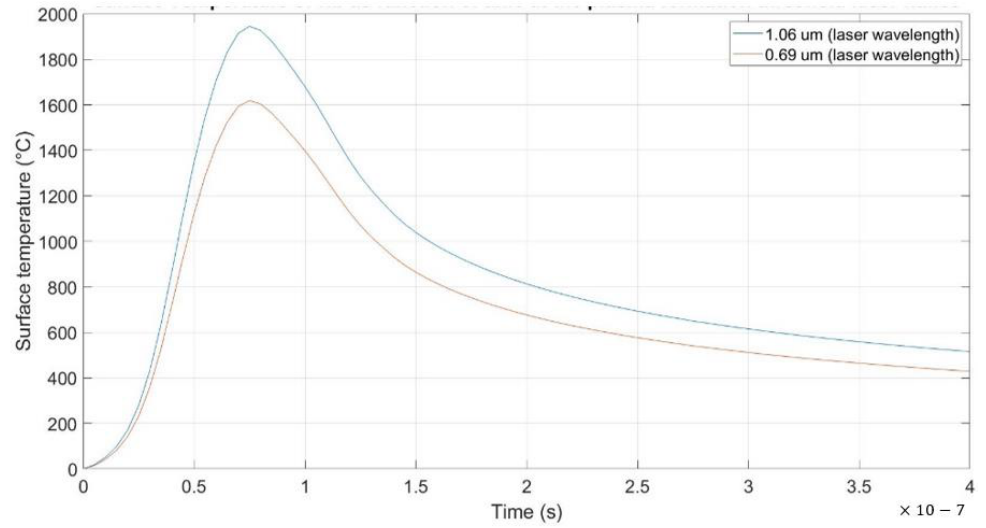
Figure 3. Computed surface temperature of the Nb samples as a function of time at the plasma formation threshold laser fluence.